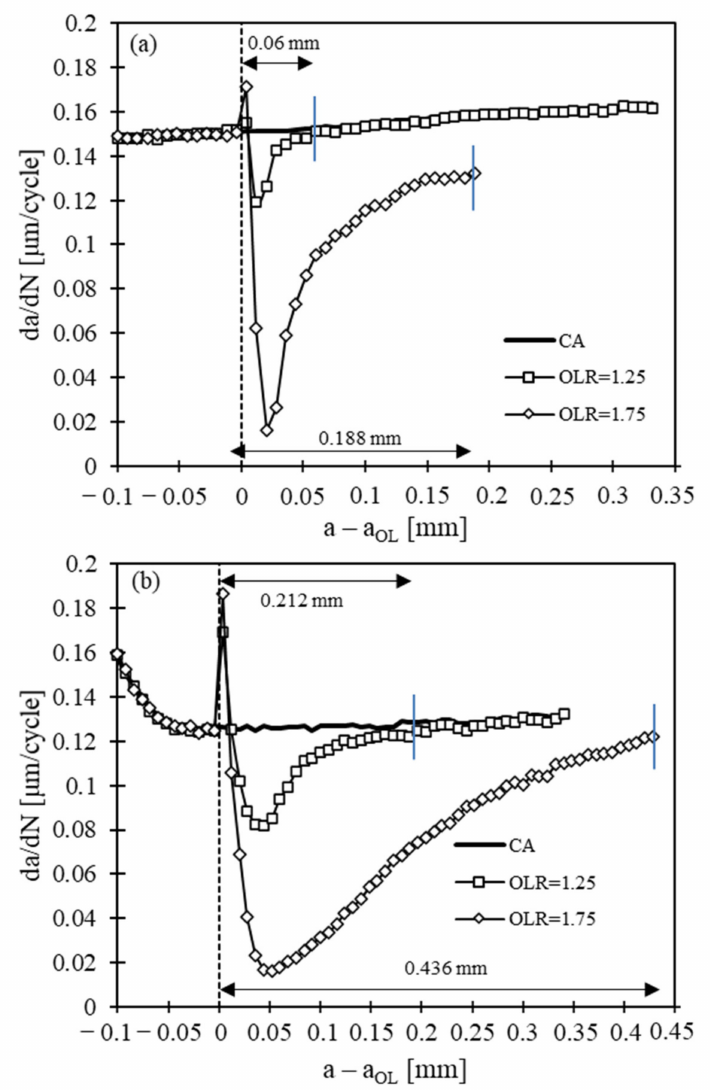
Figure 8. Numerical prediction of FCG rate with the application of a single tensile overload √ (a OL = 16.12 mm; ∆ K BL = 18.3 MPa m), applying boundary conditions for: ( a ) Plane strain state; ( b ) Plane stress state (CA = Constant Amplitude; OLR = Overload Load